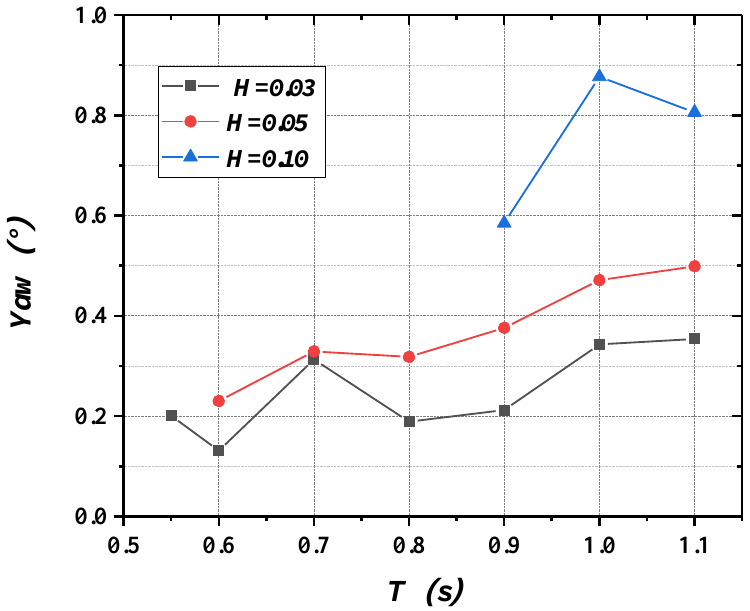
Figure 29. Variations of yaw with period and wave height.